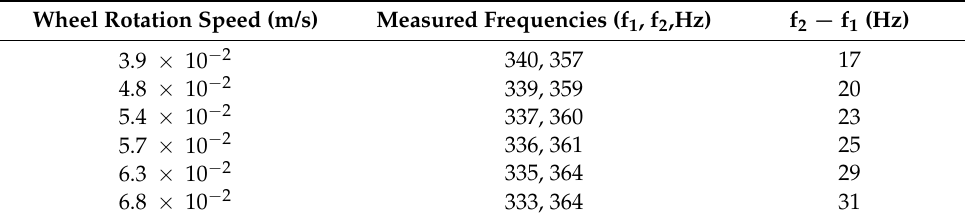
Table 2. Frequencies measured with the PSD at various wheel rotation